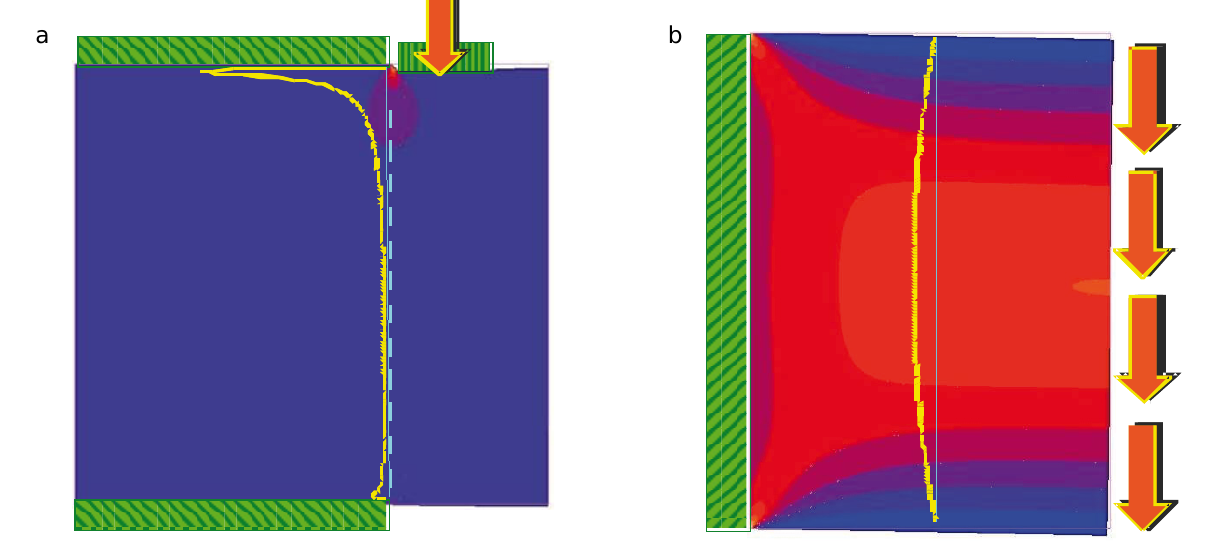
Fig 4. Shear stress distribution at the specimen head in the direct shear test (a), shear stress distribution in the direct shear test